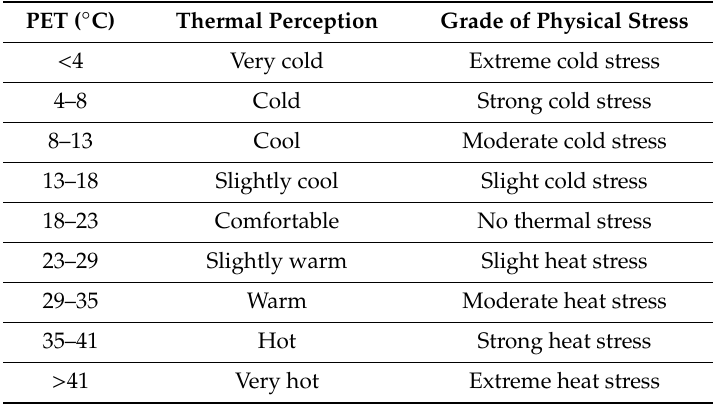
Table 1. Thermal perception and stress classification for human beings (internal heat production, 80 W; heat transfer resistance by clothing, 0.9 clo) modified after